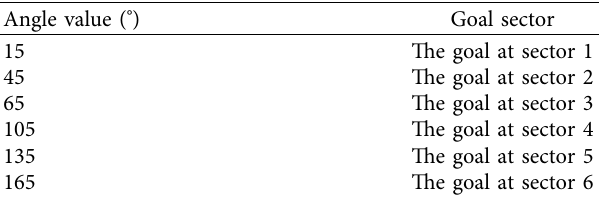
Table 5: Sample input values from the IP camera used in ANN to identify goal angle with respect to the recent mobile robot location referring to defined sectors in Table 1.